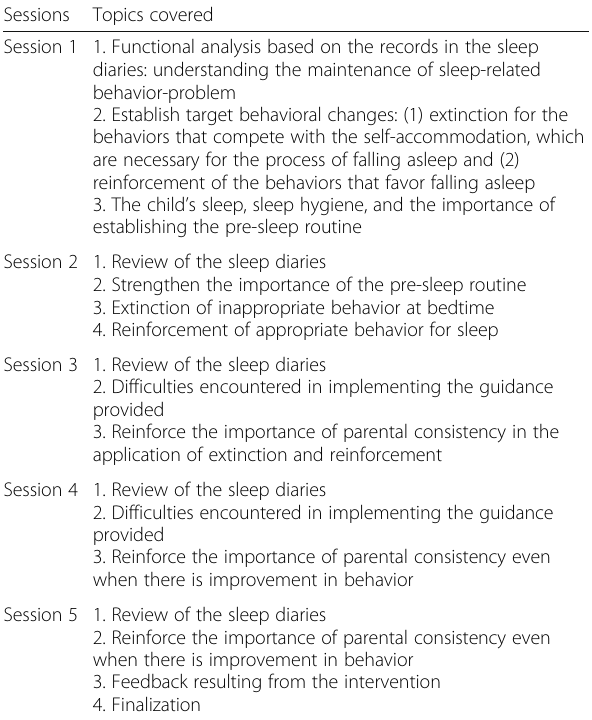
Table 1 Objectives and topics covered in the intervention program Sessions Topics